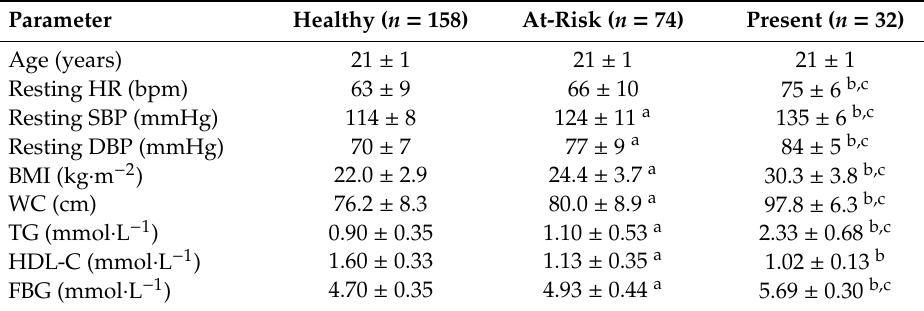
Table 2. Participant characteristics categorised by metabolic syndrome group.